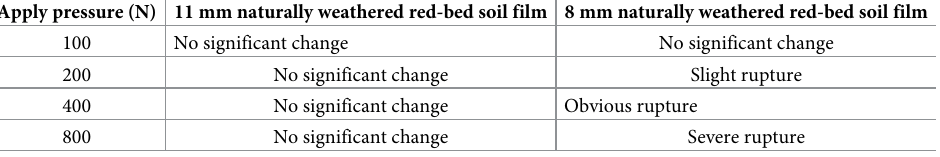
Table 5. Comparison of the compression resistances of the 8 mm film and 11 mm